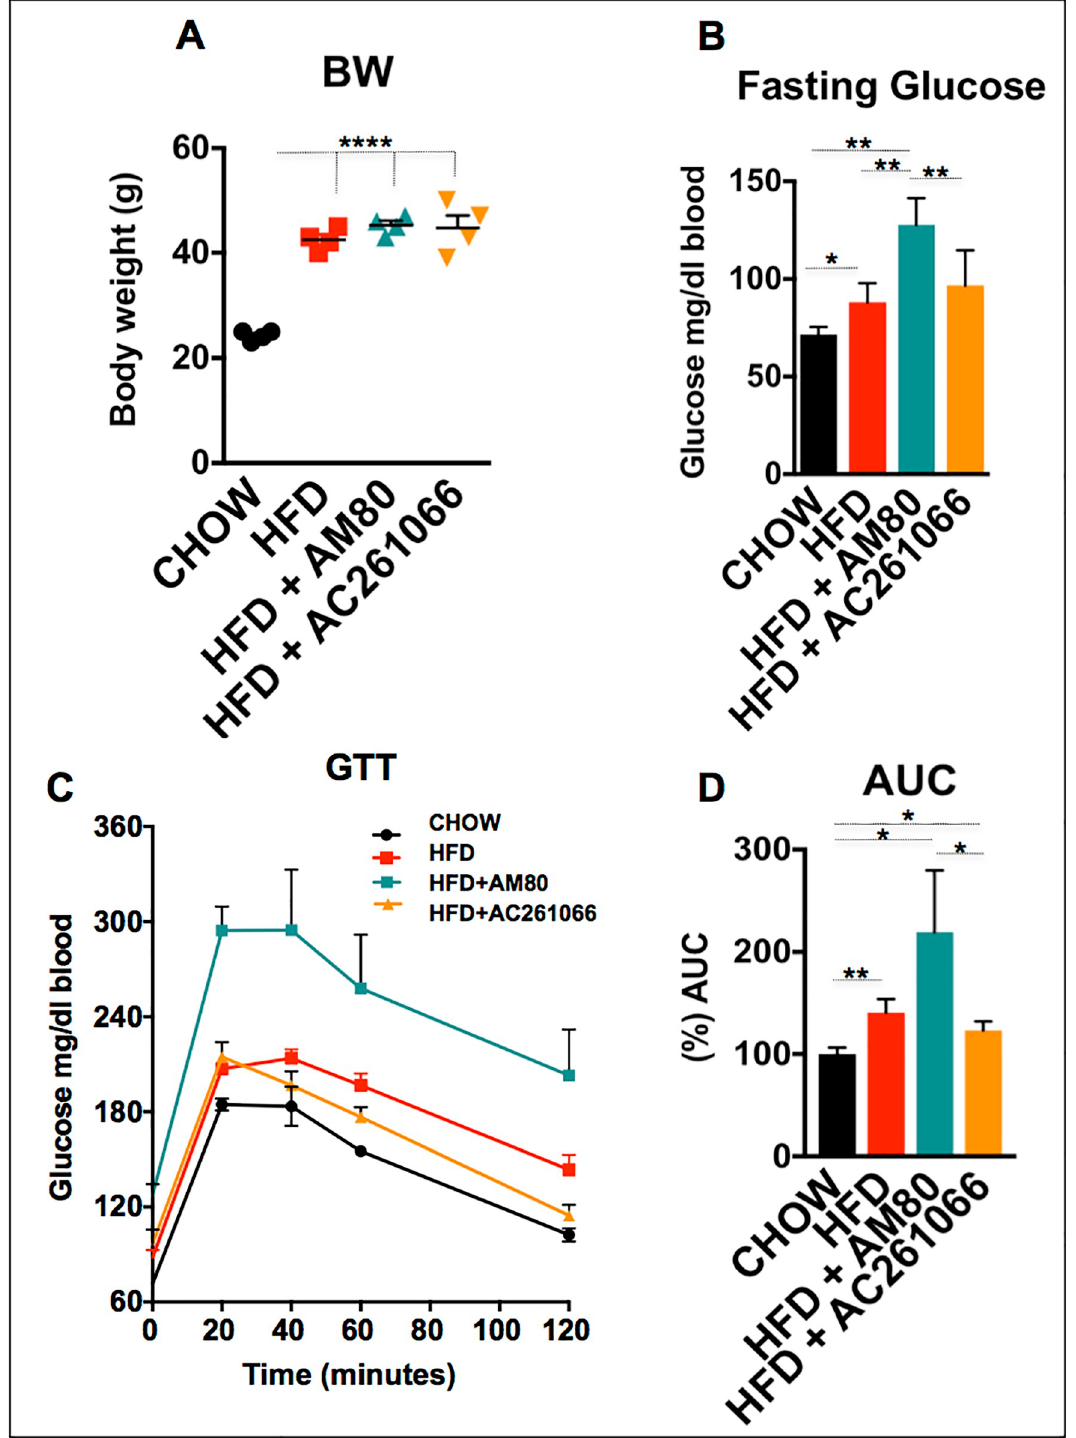
Fig 1. The RAR α agonist AM80 does not influence the body weight of HFD-fed mice, but increases the levels of fasting glucose and glucose intolerance. (A) The body weights (bw) of mice that received HFD alone, HFD+AM80, or HFD+AC261066 were increased as compared to the chow-fed mice. (B) Levels of fasting glucose in the HFD-, HFD+AM80-, and HFD+AC261066-treated as compared to chow-fed mice. (C) Glucose tolerance tests (GTT), performed after overnight fasting, with an intraperitoneal (ip) injection of 20% glucose in PBS, at 2 g glucose/Kg. (D) The quantification of the GTT is represented by the area under the